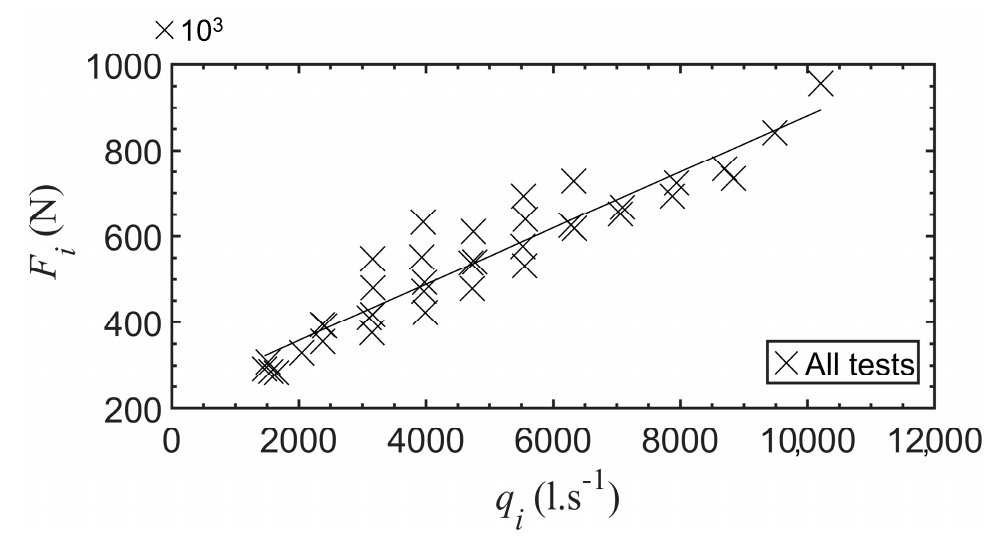
Figure 12. Scaling of the axial load at the toe section during overtopping event according to discharge values. Data extracted from Figure 6f and scaled for a dam ten times bigger (i.e., 10 m width) than the experimental model considered in this work.